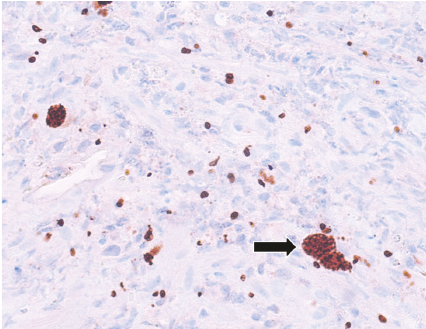
Figure 1: Abdominal computed tomography showing diffuse cir- cumferential thickening of the colonic wall. The arrows refer to circumferential thickening of the transverse colon.